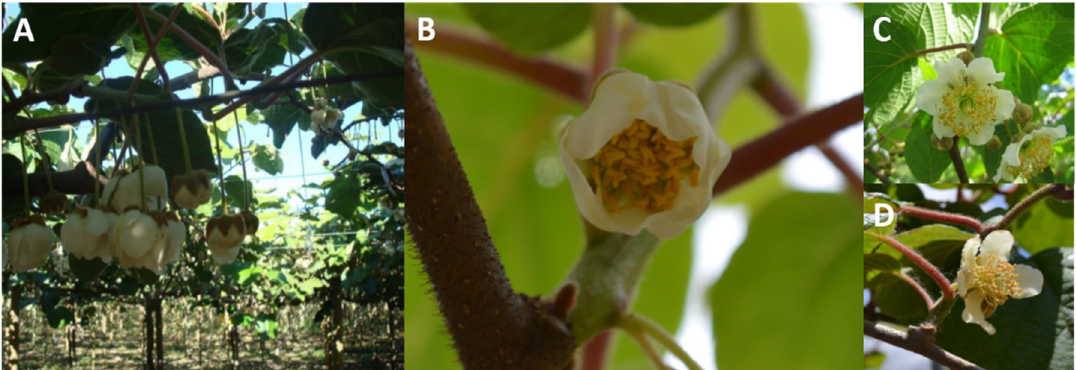
Figure 1. ( A ) Experimental orchard where the crossings took place (Curicó, VII region of Chile). ( B ) Phenological state of female and male flowers with corolla bell-shaped (60). ( C – D ) Detail of ‘Hayward’ female flower ( C ) and ‘GxT’ male flower ( D ) in full flowering (65).